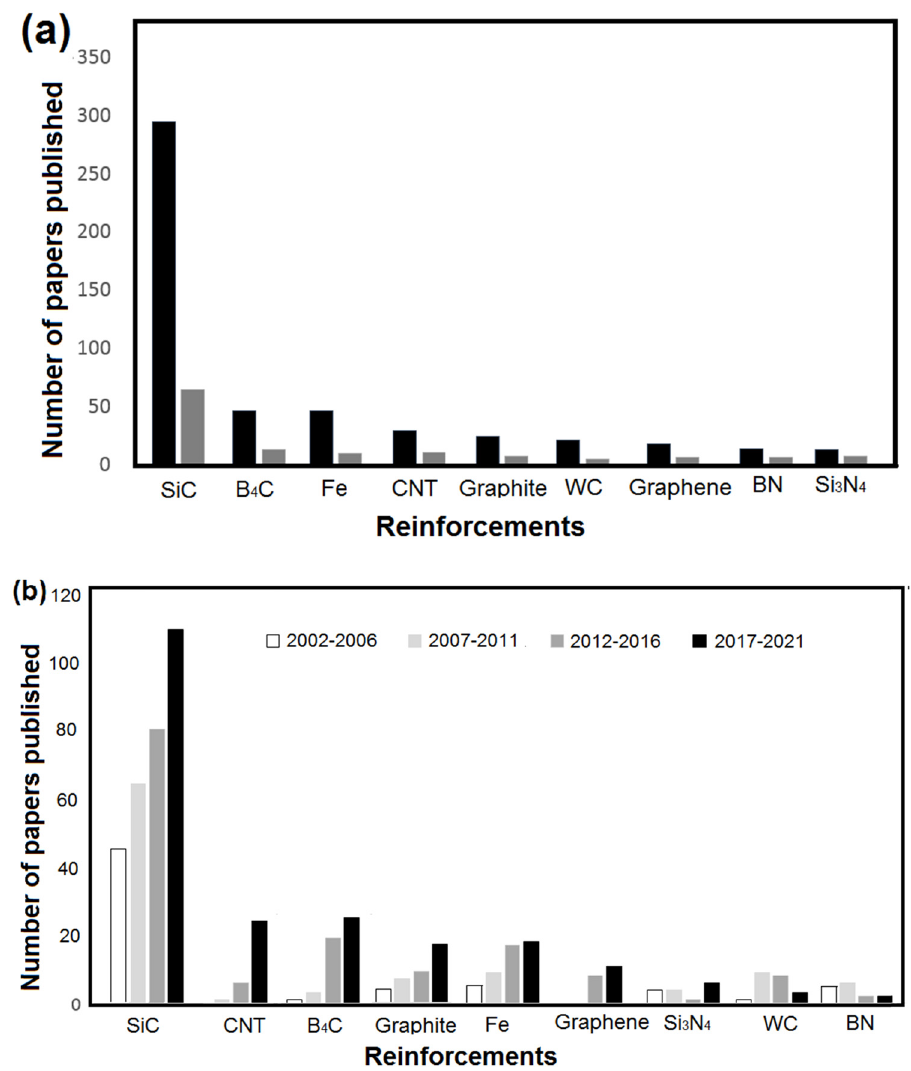
Figure 1: Number of papers published from 2002 to 2021: ( a ) on Al matrices with Si, Cu, and/or Mg reinforced with nonoxide reinforcements ( black bars ) and those papers that include the study of the interfaces ( gray bars ) . ( b ) Number of papers published on this topic for periods of 5 years, from 2002 to 2021. Source: